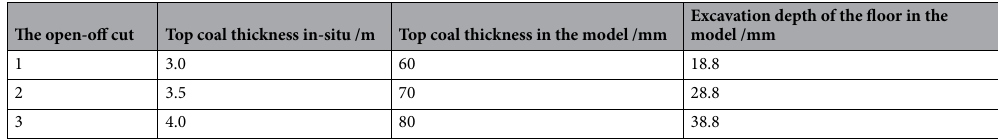
Table 2. The designed parameters of the open-off cuts in the similarity model.